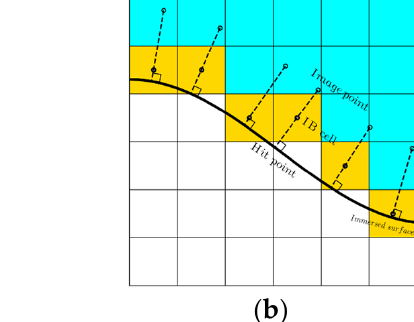
is avoided. A similar (cid:3010)(cid:3017)